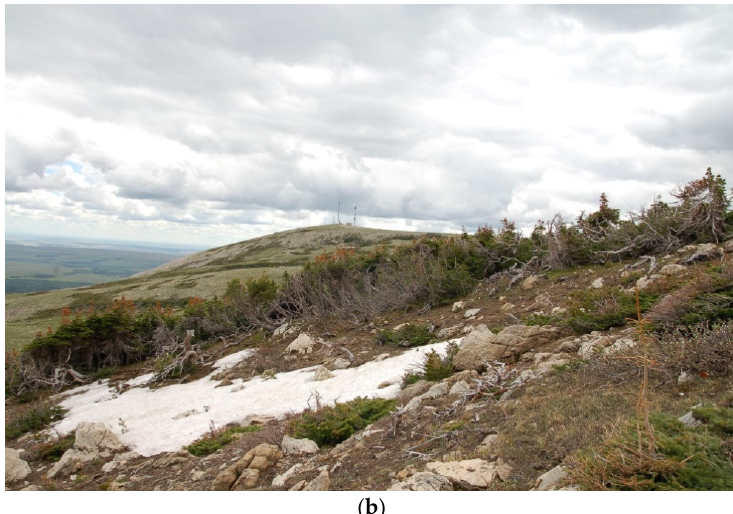
Figure 6. ( a ) Ribbon forest ATE community above Christina Lake, WY, with whitebark pine a major component after snowmelt completion in the surrounding treeless matrix (Photo: E.R. Pansing); ( b ) Whitebark pine ATE community from Divide Mountain, MT, with snowdrift in lee of tree island stringer (Photo: D.F. Tomback). Table 4. References describing snowpack deposition, redistribution, snowmelt run ‐ off, and the role of high elevation tree communities in these processes. The processes are summarized with respect to potential snow retention ecosystem services provided by whitebark pine communities in the alpine ‐ treeline ecotone.